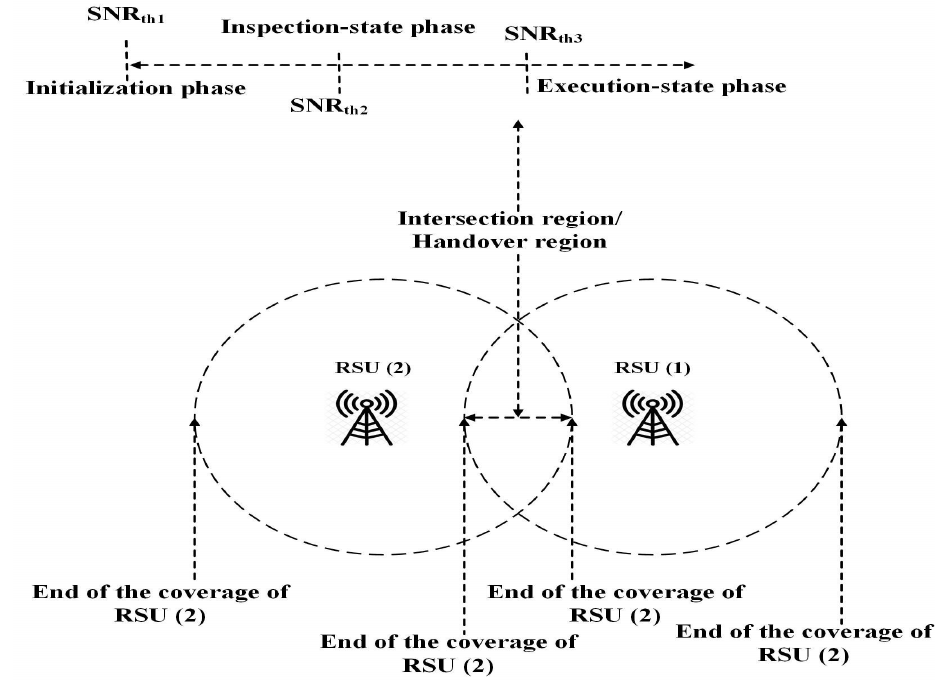
Figure 3. Handover stages at intersection of coverage regions.